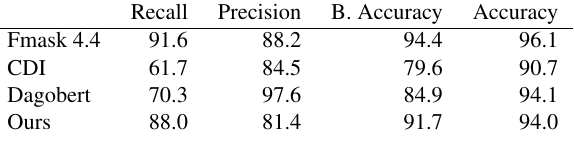
Table 1. Recall, Precision, Balanced Accuracy and Accuracy (all